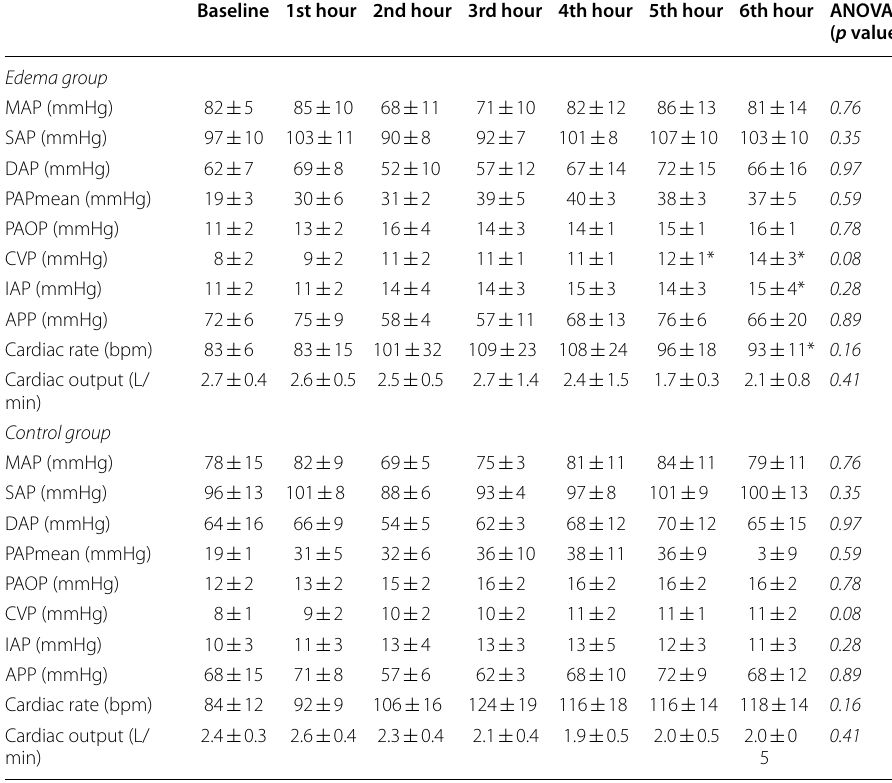
Hemodynamic parameters measured at the baseline and every hour during experiments in the two groups. Data are reported as mean; standard deviation. Statistically significant difference ( p < 0.05) between the two groups found with multiple t-tests is reported as a * near to the Intervention Group values ANOVA analysis p values are reported in the dedicated columns next to the Edema group measurements MAP mean arterial pressure, SAP systolic arterial pressure, DAP diastolic arterial pressure, PAPmean pulmonary artery pressure (mean value), PAOP pulmonary artery occlusion pressure, CVP central venous pressure, IAP intra-abdominal pressure, APP abdominal perfusion pressure, mmHg millimeter mercury, bpm beat per minute, L/min liters per